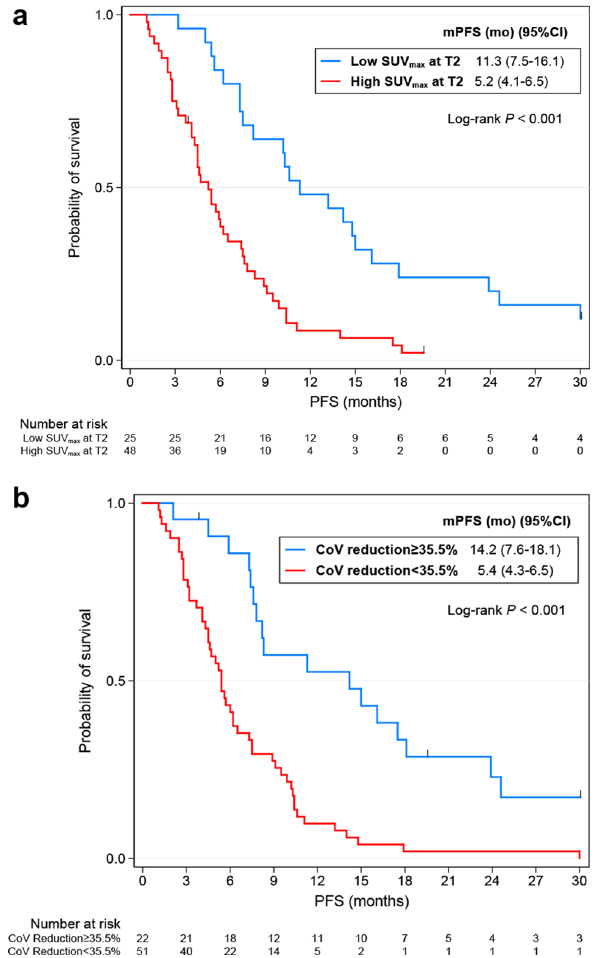
Figure 3. Kaplan–Meier survival curves for progression-free survival according to SUV max at TP2 ( a ) and the percent change in CoV ( b ). SUV standardized uptake value, CoV coefficient of